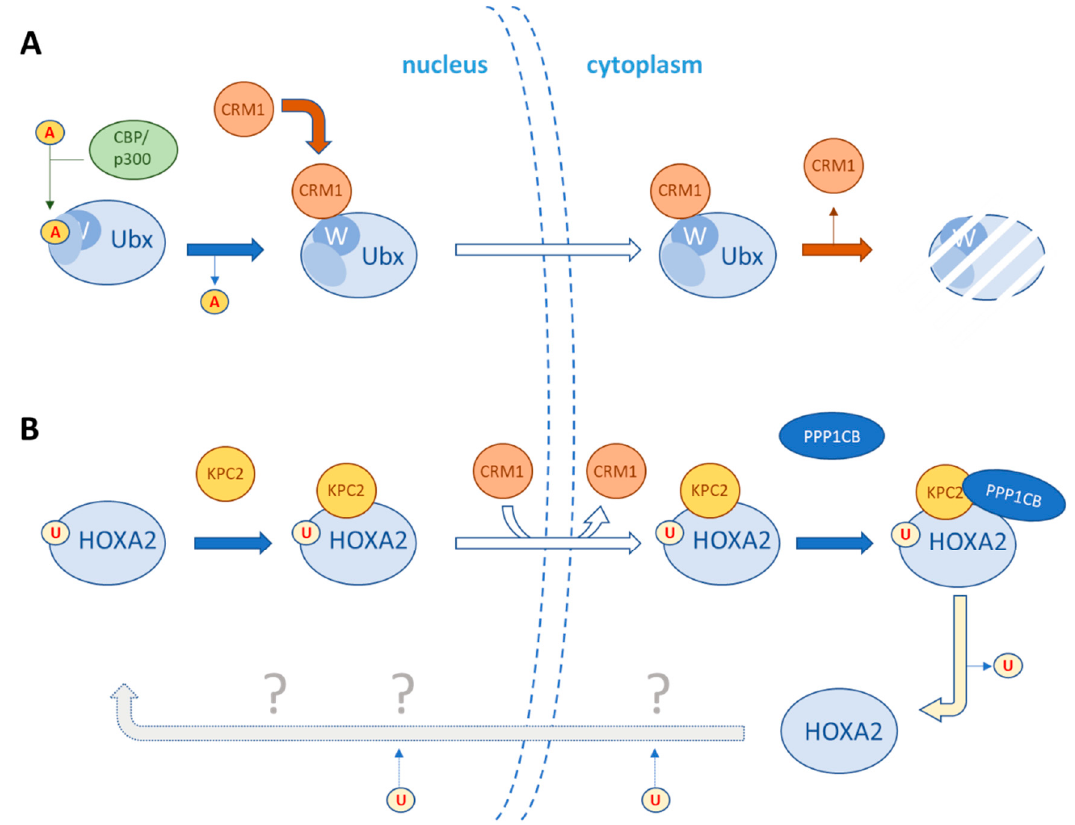
Figure 2. The nuclear exit of Ubx and HOXA2 proteins is a regulated process. ( A ) The nuclear exit of Ubx relies on its interaction with the CRM1/Embargoed exportin involving the PBX/Exd interaction motif, a hexapeptide characterized by an extremely conserved Tryptophan residue (“W”). Accessibility of this hexapeptide is a regulated process involving the acetylation/deacetylation of Ubx. The acetyl-transferase CBP/p300 contributes to this regulatory protein modification. Once in the cytoplasm, Ubx is degraded (see text for details) [49]. ( B ) Model for the activity regulation of HOXA2. HOXA2 interacts with KPC2 in the nucleus, which stimulates its CRM1-dependent nuclear exit. In the cytoplasm, the HOXA2–KPC2 complex is recognized by PPP1CB, which, in turn, promotes the de-ubiquitination of HOXA2. This would establish a ready-to-use supply of HOXA2, which can be primed for nuclear re-entry and transcriptional activity (see text for details)